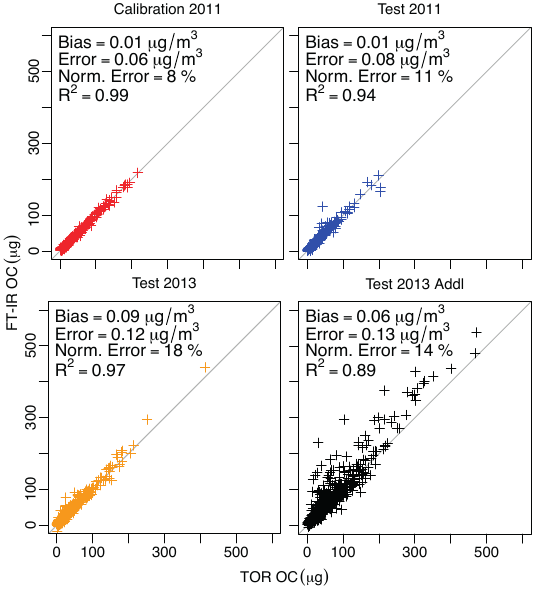
Figure 2. Scatter plots and performance metrics between FT-IR OC and TOR OC for the four data sets described in Sect. 2.1. Concentra- tion units of µgm − 3 for bias and error are based on the IMPROVE nominal volume of 32.8m 3